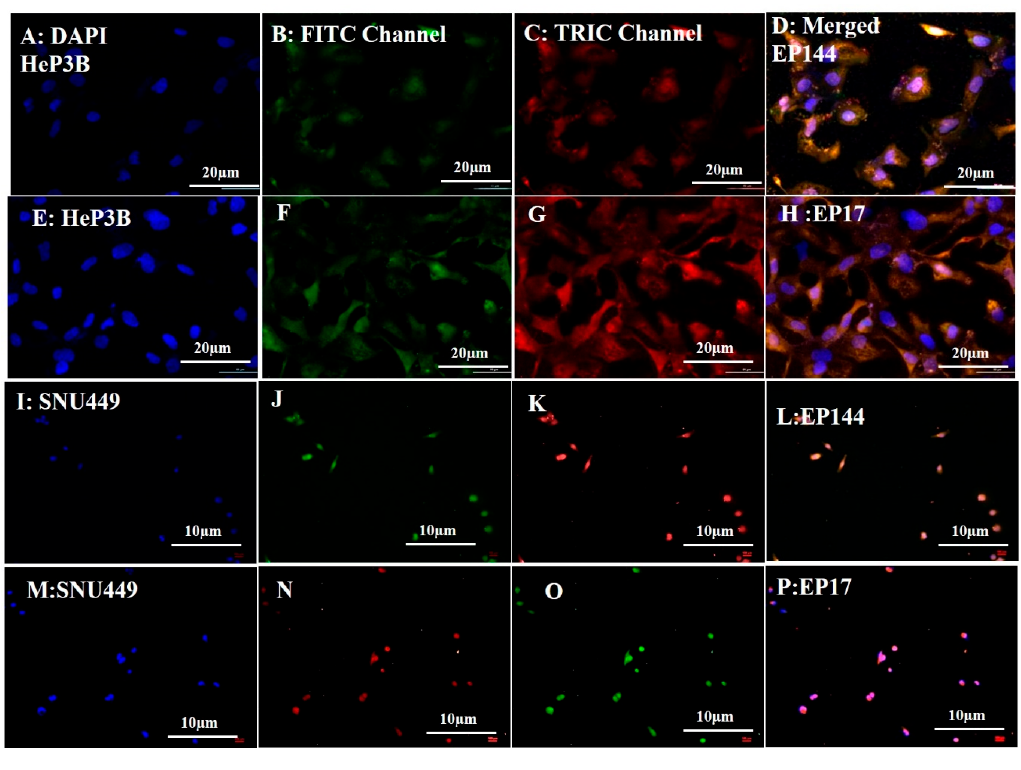
Figure 4. Fluorescence images of cellular uptake ( A – D ) Hep3B adsorbed EP144. ( E – H ) Hep3B adsorbed EP17. ( I – L ) SNU449-adsorbed EP144. ( M – P ) SNU449-adsorbed EP17.